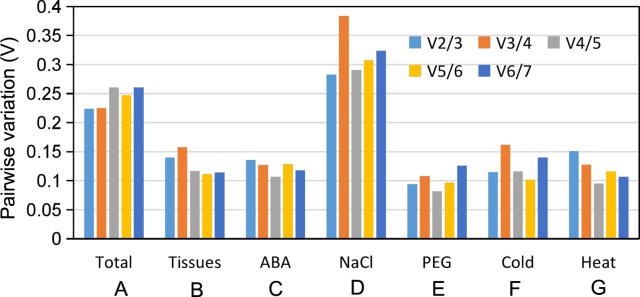
Estimation of the required number of reference genes for normalization by pairwise variation (V) using geNorm.